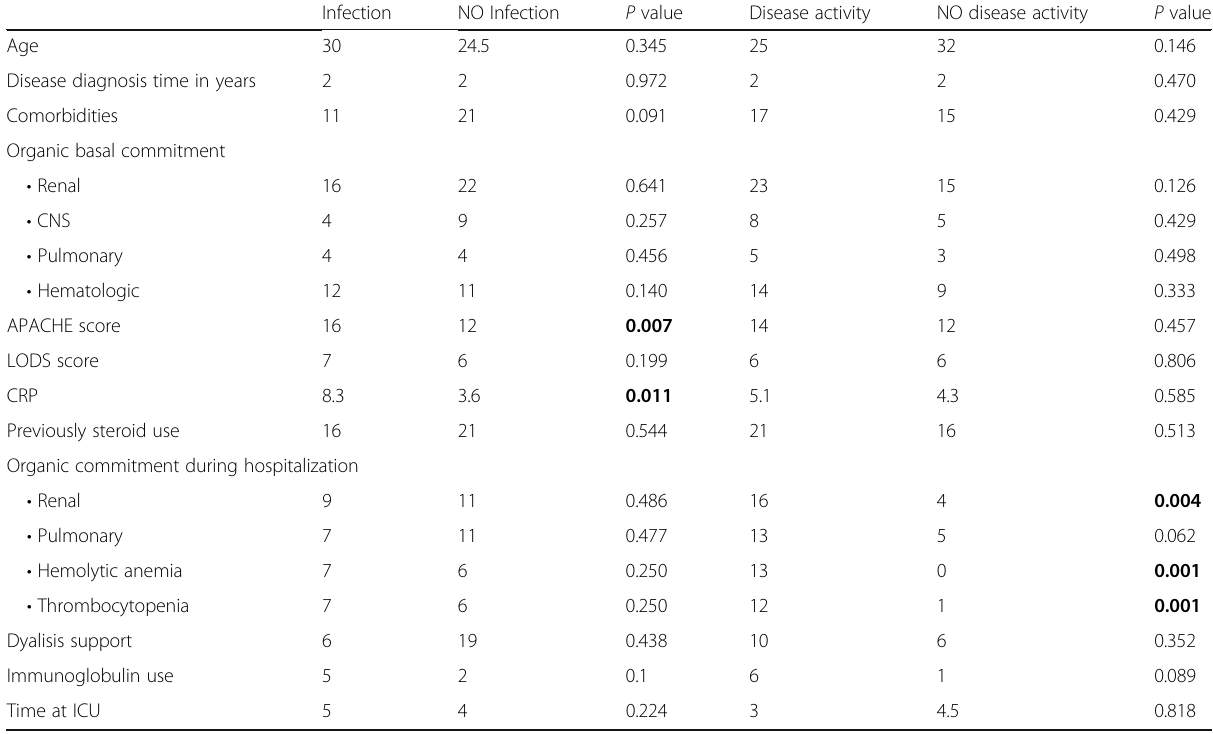
Table 5 Comparison of principals reasons for admission and main variables Infection Disease